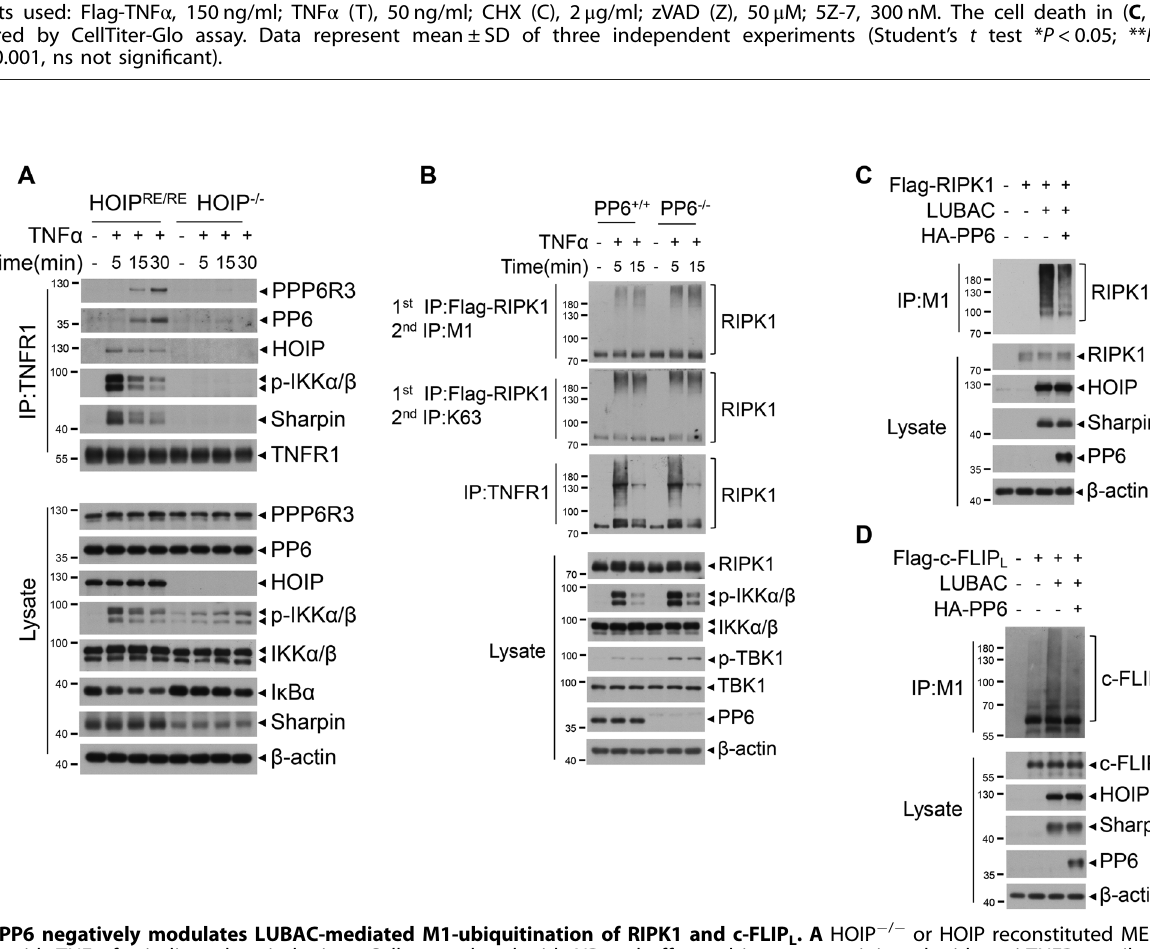
Fig. 5 HOIP is required for PP6 to regulate RIPK1 activation and c-FLIP L degradation. A PP6 + / + or PP6 − / − MEFs were treated with TNF α for indicated periods of time. Cells were lysed with NP-40 buffer and immunoprecipitated with anti-Flag beads. The immunocomplexes and whole-cell lysates were analyzed by western blotting with indicated antibodies. B Control vector, WT-PP6 or D84N-PP6 reconstituted PP6 − / − MEFs were treated with TNF α for indicated periods of time. Cells were lysed with NP-40 buffer and immunoprecipitated with anti-TNFR1 antibody. The immunocomplexes and whole-cell lysates were analyzed by western blotting with indicated antibodies. C PP6 was removed in HOIP − / − MEFs and HOIP reconstituted MEFs. Cells were then treated with TNF α /5Z-7 and TNF α /zVAD/5Z-7 for 6 h or TNF α /CHX for 10 h. D , E HOIP − / − sgGFP MEFs or HOIP − / − sgPP6 MEFs were treated with TNF α /5Z-7 or TNF α /CHX for indicated periods of time. Cell were lysed with RIPA buffer and analyzed by western blotting with indicated antibodies. F FLAG-PP6 was co-expressed with HA-Sharpin or HA-HOIP in 293T cells for 24 h. Cells were lysed with NP-40 lysis buffer and immunoprecipitated with anti-HA beads. The immunocomplexes and whole- cell lysates were analyzed by western blotting with indicated antibodies. G FLAG-tagged PP6 was co-expressed with HA tagged WT or truncated (1-704 or 1-864) HOIP in 293T cells for 24 h. Cells were lysed with NP-40 lysis buffer and immunoprecipitated with anti-HA beads. The immunocomplexes and whole-cell lysates were analyzed by western blotting with indicated antibodies. H HOIP knockout MEFs reconstituted with HOIP(WT) or HOIP(1-864) truncation and with PP6 knockout were then treated with TNF α /5Z-7 for 8 h. Concentrations of reagents used: Flag-TNF α , 150 ng/ml; TNF α (T), 50 ng/ml; CHX (C), 2 μ g/ml; zVAD (Z), 50 μ M; 5Z-7, 300 nM. The cell death in ( C , H ) was